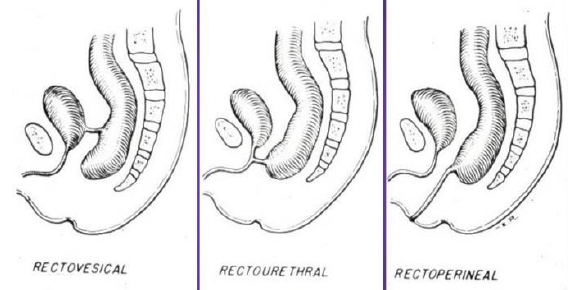
Figure 2: Gross and Ladd Textbook, Drawings of the anat- omy of anorectal malformations.